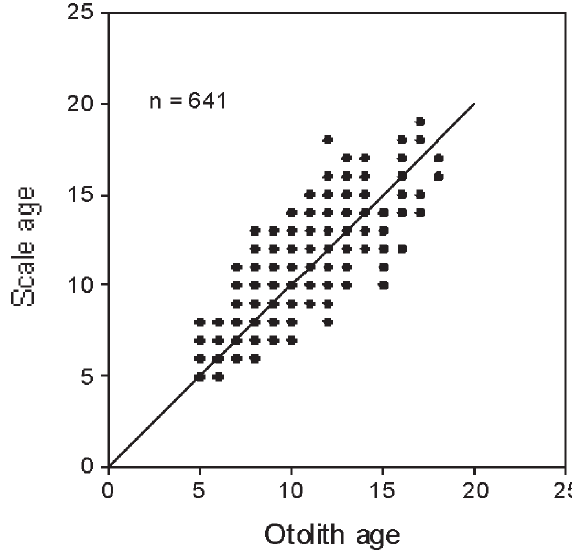
F IG . 4. – Individual age determined from scales and from otoliths. Line is scale age = otolith age.